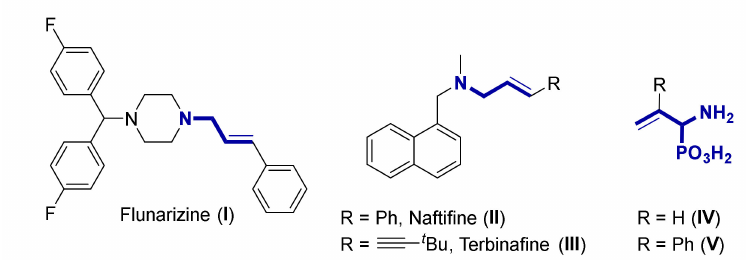
Figure 1. Representative examples of drugs containing allylic amine or allylic α -aminophosphonic acid